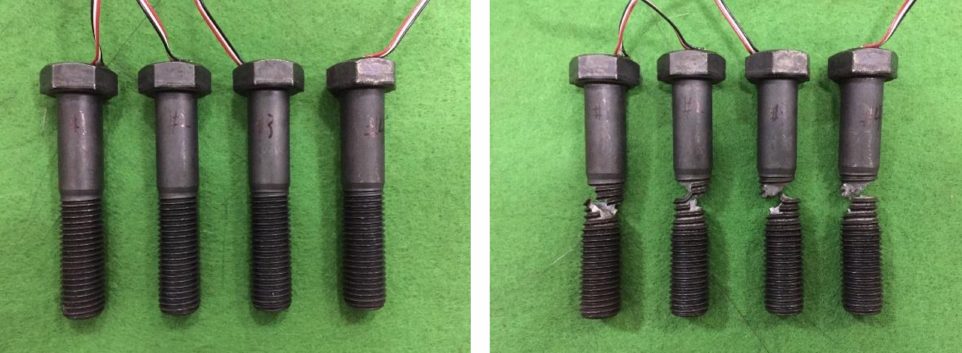
Figure 4. Results of tensile tests.